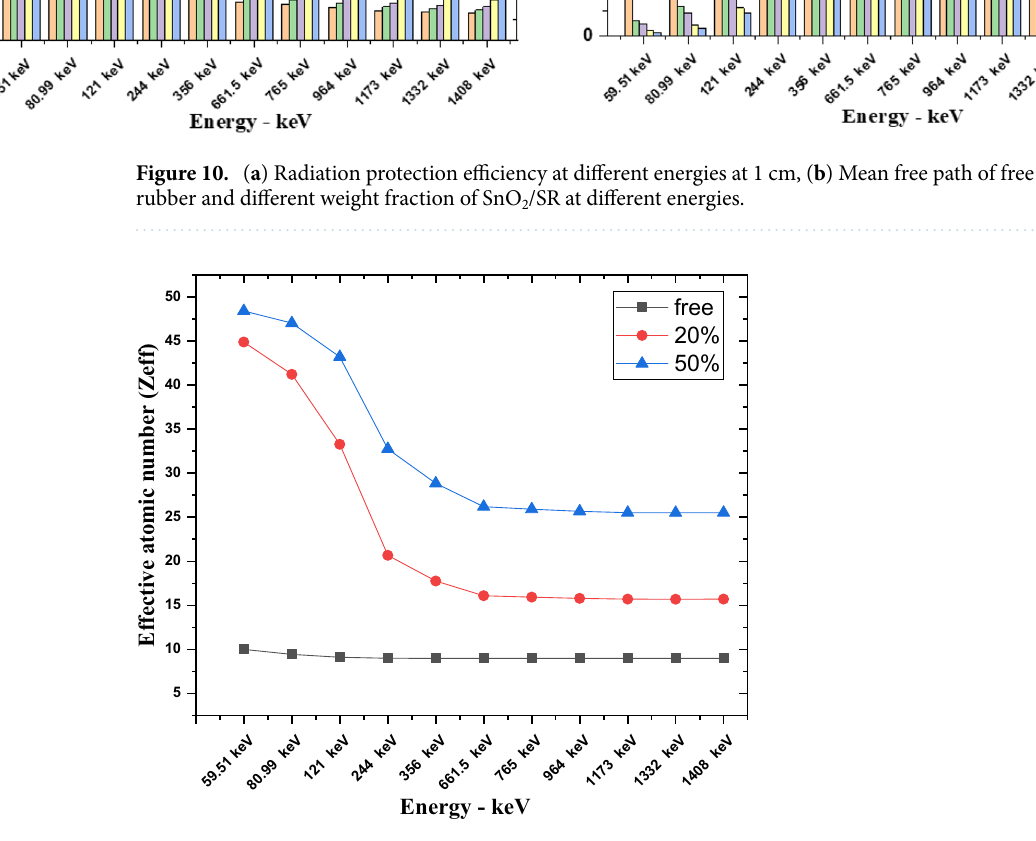
Figure 11. Effective atomic number of free silicon rubber and different weight fraction of SnO 2 /SR at different